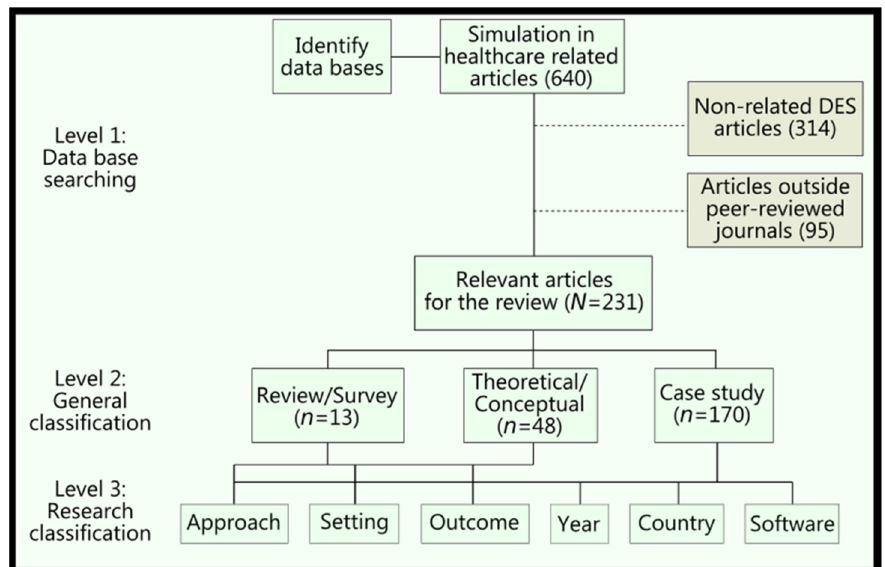
Figure 1. Inclusion and classification process of the